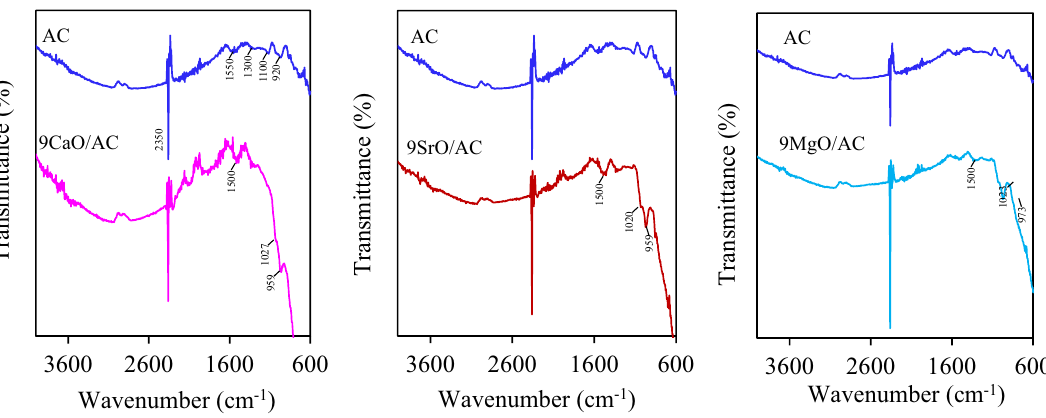
Figure 3. Representative FTIR spectra of the AC 27 and 9MO/AC samples.